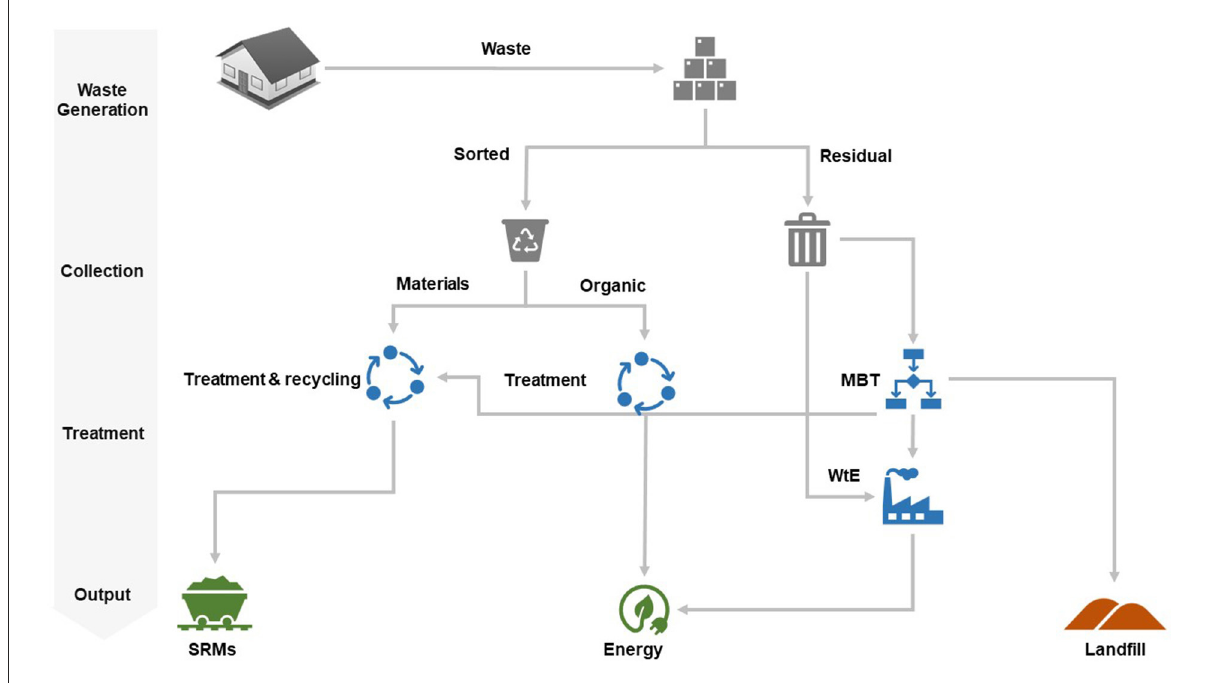
FIGURE3 The waste management system.